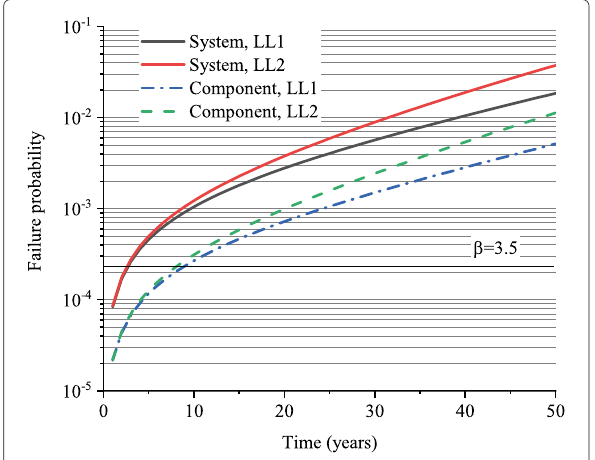
Fig. 3 Time-dependent failure probabilities of a 5-out-of-5 (series) system and a single